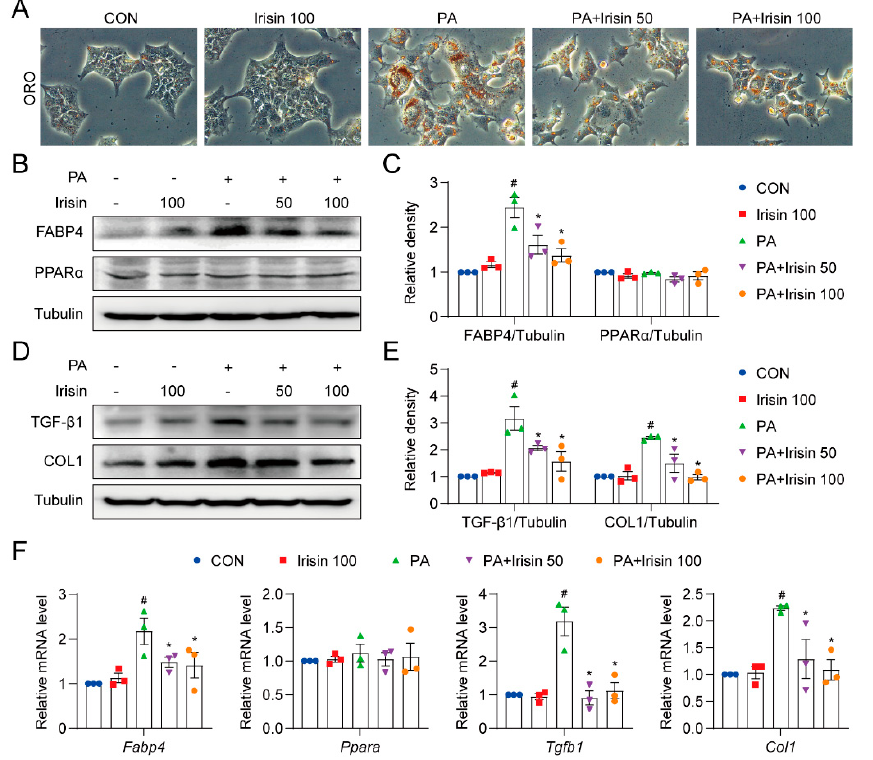
Figure 6. Irisin decreases steatosis and fibrosis in AML12 cells. ( A – C ) AML12 cells were pretreated with recombinant irisin (50 or 100 ng/mL) for 30 min followed by exposure to 200 µ M PA for 36 h. ( A ) Representative images of AML12 stained by Oil Red O (400 × ). ( B , C ) Protein levels of FABP4 and PPAR α in AML12 cells. ( D , E ) Protein levels of TGF- β 1 and COL1 in AML12 cells. Tubulin was used as the loading control. ( F ) AML12 cells were pretreated with recombinant irisin (50 or 100 ng/mL) for 30 min followed by exposure to 200 µ M PA for 12 h. Relative mRNA levels of Fabp4, Ppara, Tgfb1, and Col1 were detected. The data are presented as the mean ± SEM. # p < 0.05 vs. CON group; * p < 0.05 vs. PA group.